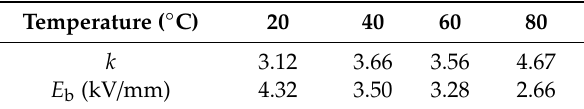
Figure 5. J–E curves of the epoxy/SiC composite samples at different temperatures with a filler content of ( a ) 60 and ( b ) 150 phr. Table 6. The non-linear coefficient k and the threshold field E b of the sample at different temperatures with α -SiC content of 60 phr.